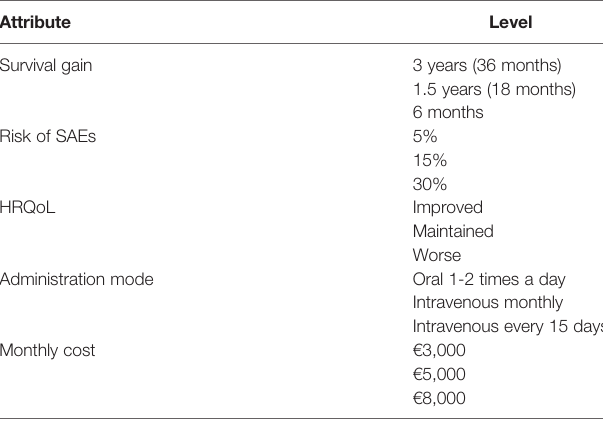
TABLE 1 | Attributes and levels included in the